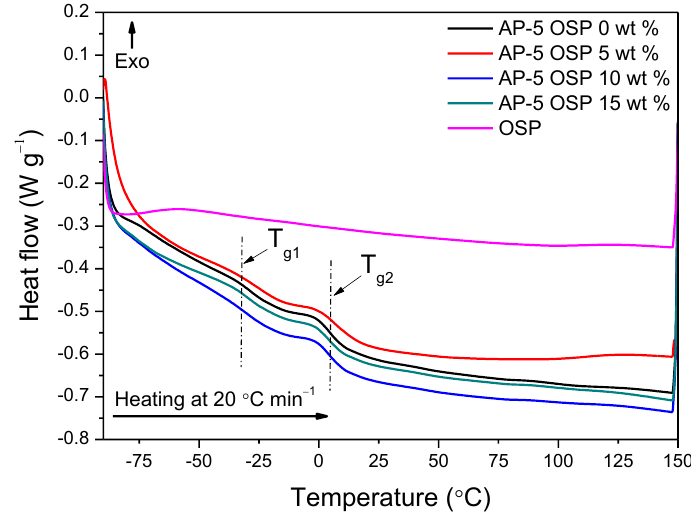
Figure 15. DSC thermograms of OSP, neat asphalt, and OSP-filled asphalts.